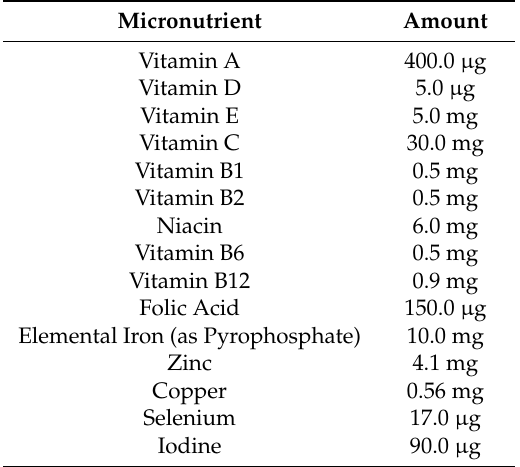
Table 1. Micronutrient composition per 1 g sachet of